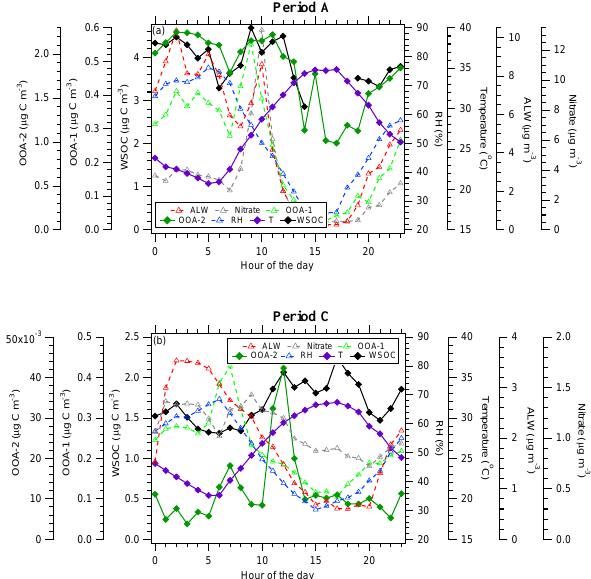
Figure 12. Diurnal profile of WSOC, OOA-1, OOA-2, RH, temper- ature, ALW, and nitrate for (a) Period A and (b) Period C at SPC.